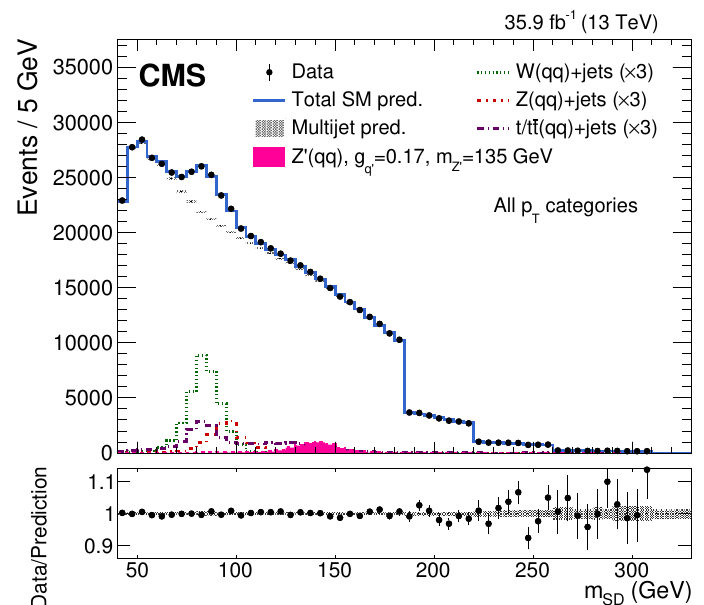
Figure 10 . Soft-drop jet mass distribution for the passing region and combined p T categories. The multijet background prediction in the passing region is obtained using the failing region and the pass-fail ratio R ( m SD ; p T ). Data are shown as black points. The multijet background prediction, p = f including uncertainties, is shown by the shaded bands. Contributions from the W and Z boson, and top quark background processes are shown, scaled up by a factor of 3 for clarity. A hypothetical Z 0 boson signal at a mass of 135 GeV is also indicated. The features at 45, 185, 220 and 255 GeV in the m SD distribution are due to the kinematic selection on (cid:26) , which a(cid:11)ects each p T category di(cid:11)erently. In the bottom panel, the ratio of the data to the background prediction, including uncertainties, is shown.